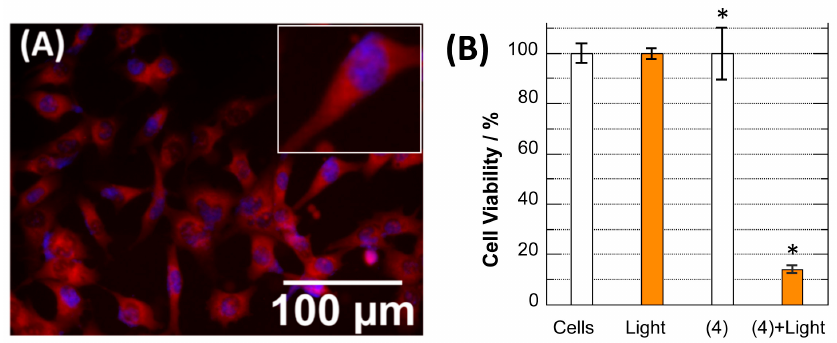
Figure 9. ( A ) A representative superimposed fluorescence microscopy image reveals intracellular dye localization (red) in ES-2 ovarian clear cell adenocarcinoma cells after incubation with 0.5 µ g / mL of dye 4 for 24 h followed by staining nuclei with Hoechst 33342 (blue). Inset: The enlarged area of one cell within the fluorescence microscopy image. ( B ) ES2 cancer cell viability for: Cells, no treatment; Light, cells exposed to a 694-nm laser (~1.3 W / cm 2 ) for 5 min; ( 4 ), cells incubated with dye 4 (0.5 µ g / mL = 0.9 µ M) for 24 h under dark conditions; and ( 4 ) + Light, cells incubated with dye 4 (0.5 µ g / mL) for 24 h and exposed to a 694-nm laser (1.3 W / cm 2 ) for 5 min. * p < 0.05 when compared with non-treated cells. Error bars represent standard deviation.